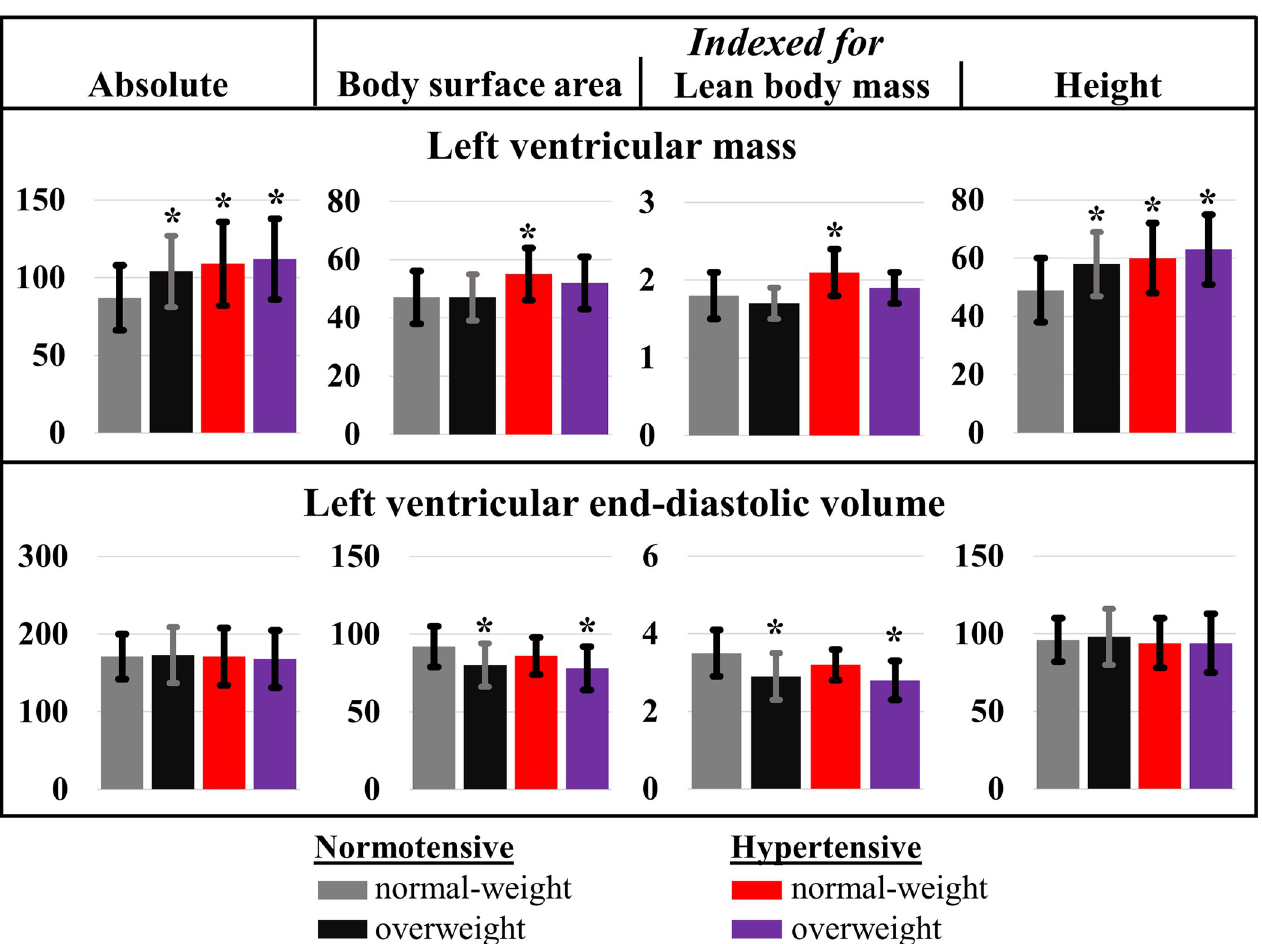
Fig 1. Indexation of left ventricular (LV) mass (upper panel) and LV end-diastolic volume (lower panel) for several body scales in the four study groups. Indexation for height 1.7 and height 2.7 were not included in the graph, since these results were similar to the height-indexed results. Bonferroni post-hoc tests: � P < 0.05 vs normotensive